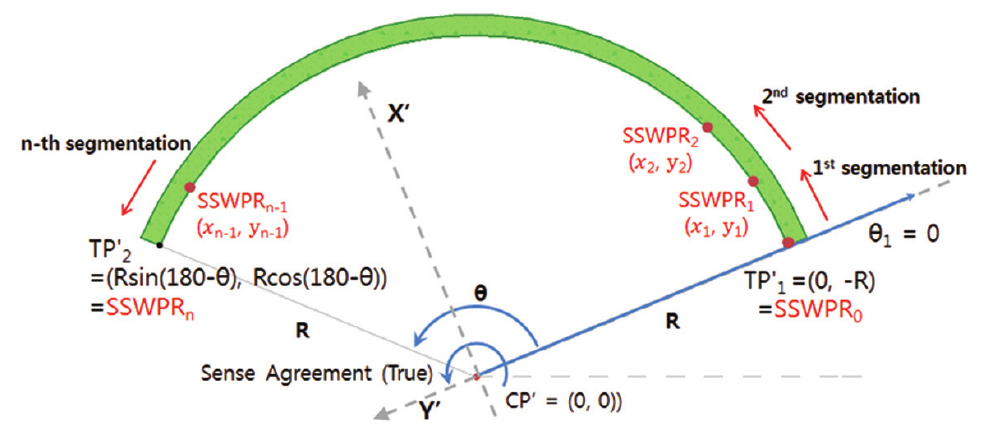
Fig. 5. Concept of rotated SSWPR n based on